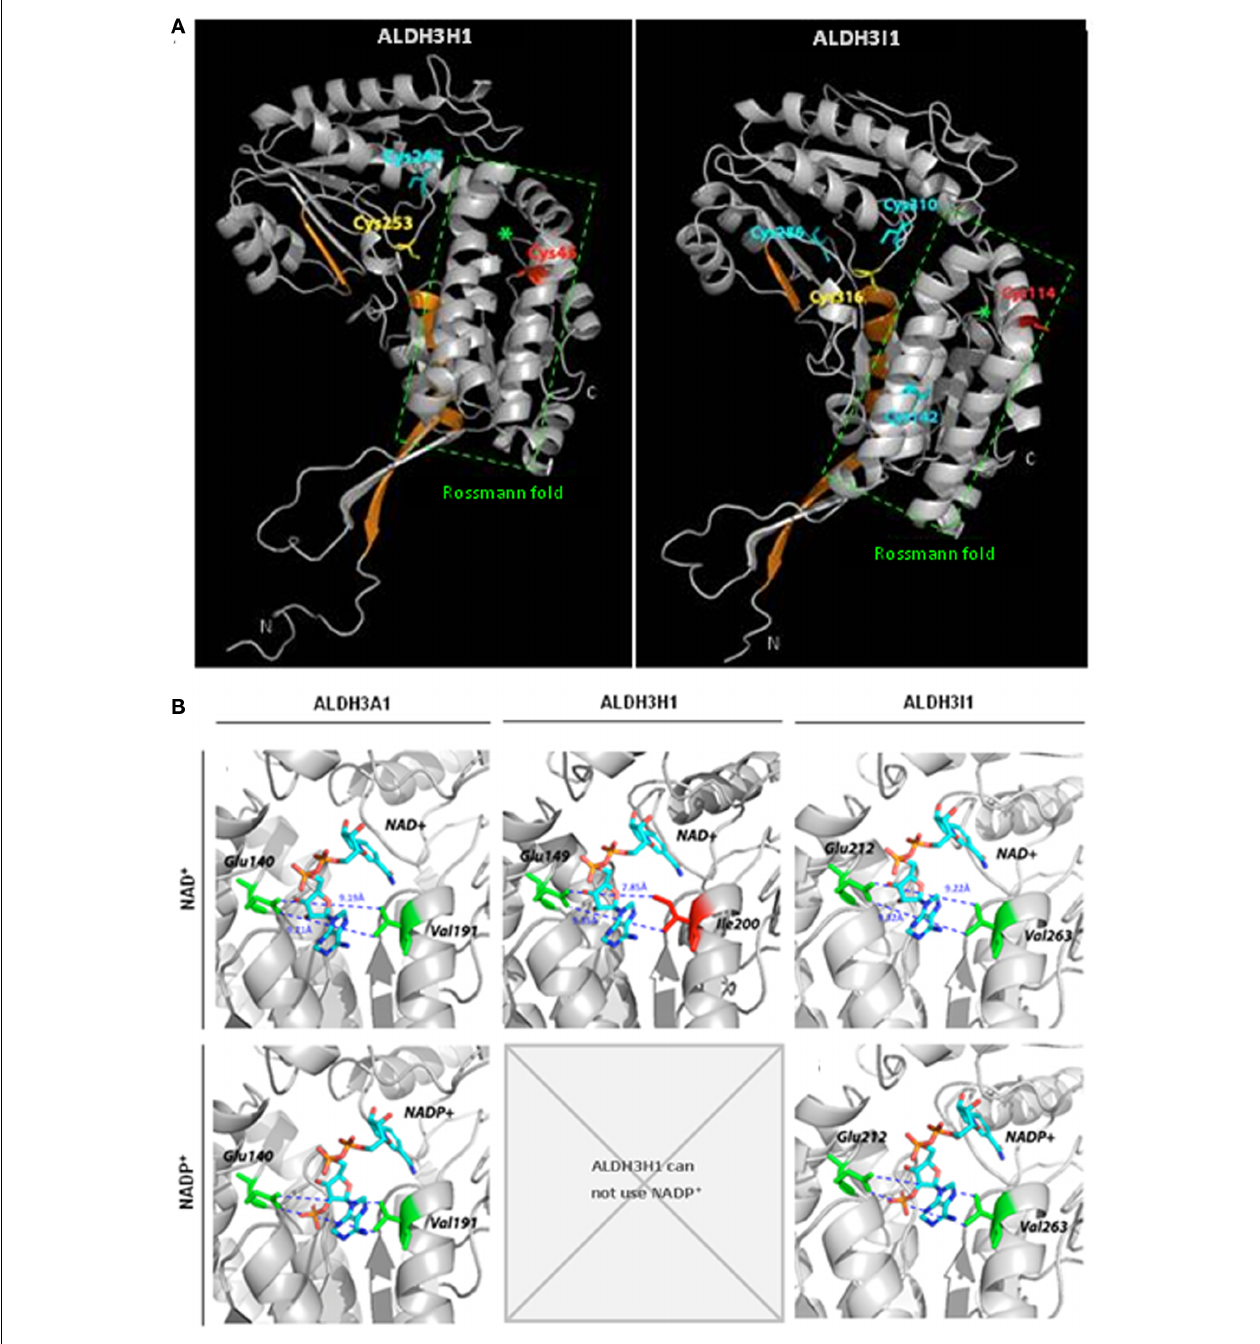
functional native homologous ALDH3A1 protein. (B) Location of NAD + and NADP + and amino acid residues in the coenzyme binding cleft of the previously reported structure of ALDH3A1 from Rattus norvegicus and the predicted structures of ALDH3H1 and ALDH3I1.The predicted structures of ALDH3H1 and ALDH3I1 were built using the crystal structure of Rattus norvegicus ALDH3A1 as template. (This figure was redrawn from Stiti et al., 2011, permission to reproduce the figure was obtained from Portland